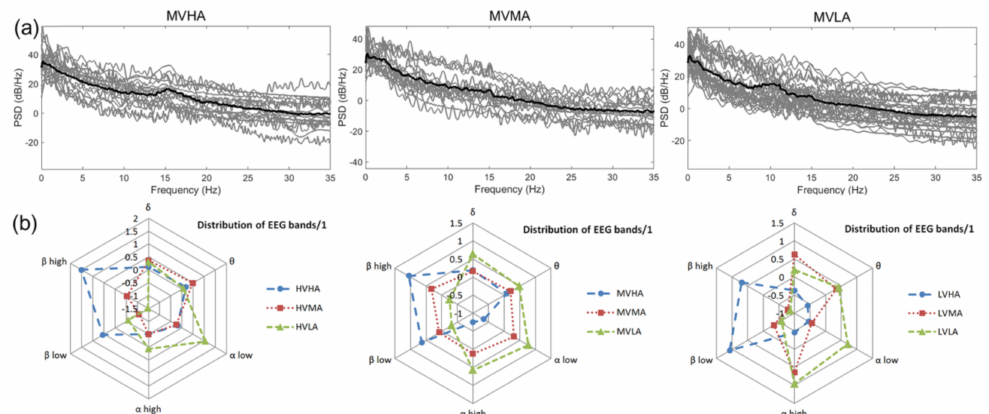
Figure 4. Distribution characteristics of EEG in various emotional states: ( a ) shows the distribution characteristics of power spectral density under three typical emotional states (grey is the measured value and black is the mean value); and ( b ) is the distribution diagram of the change of the average power of each band of EEG relative to the baseline power under various emotional states (10log10